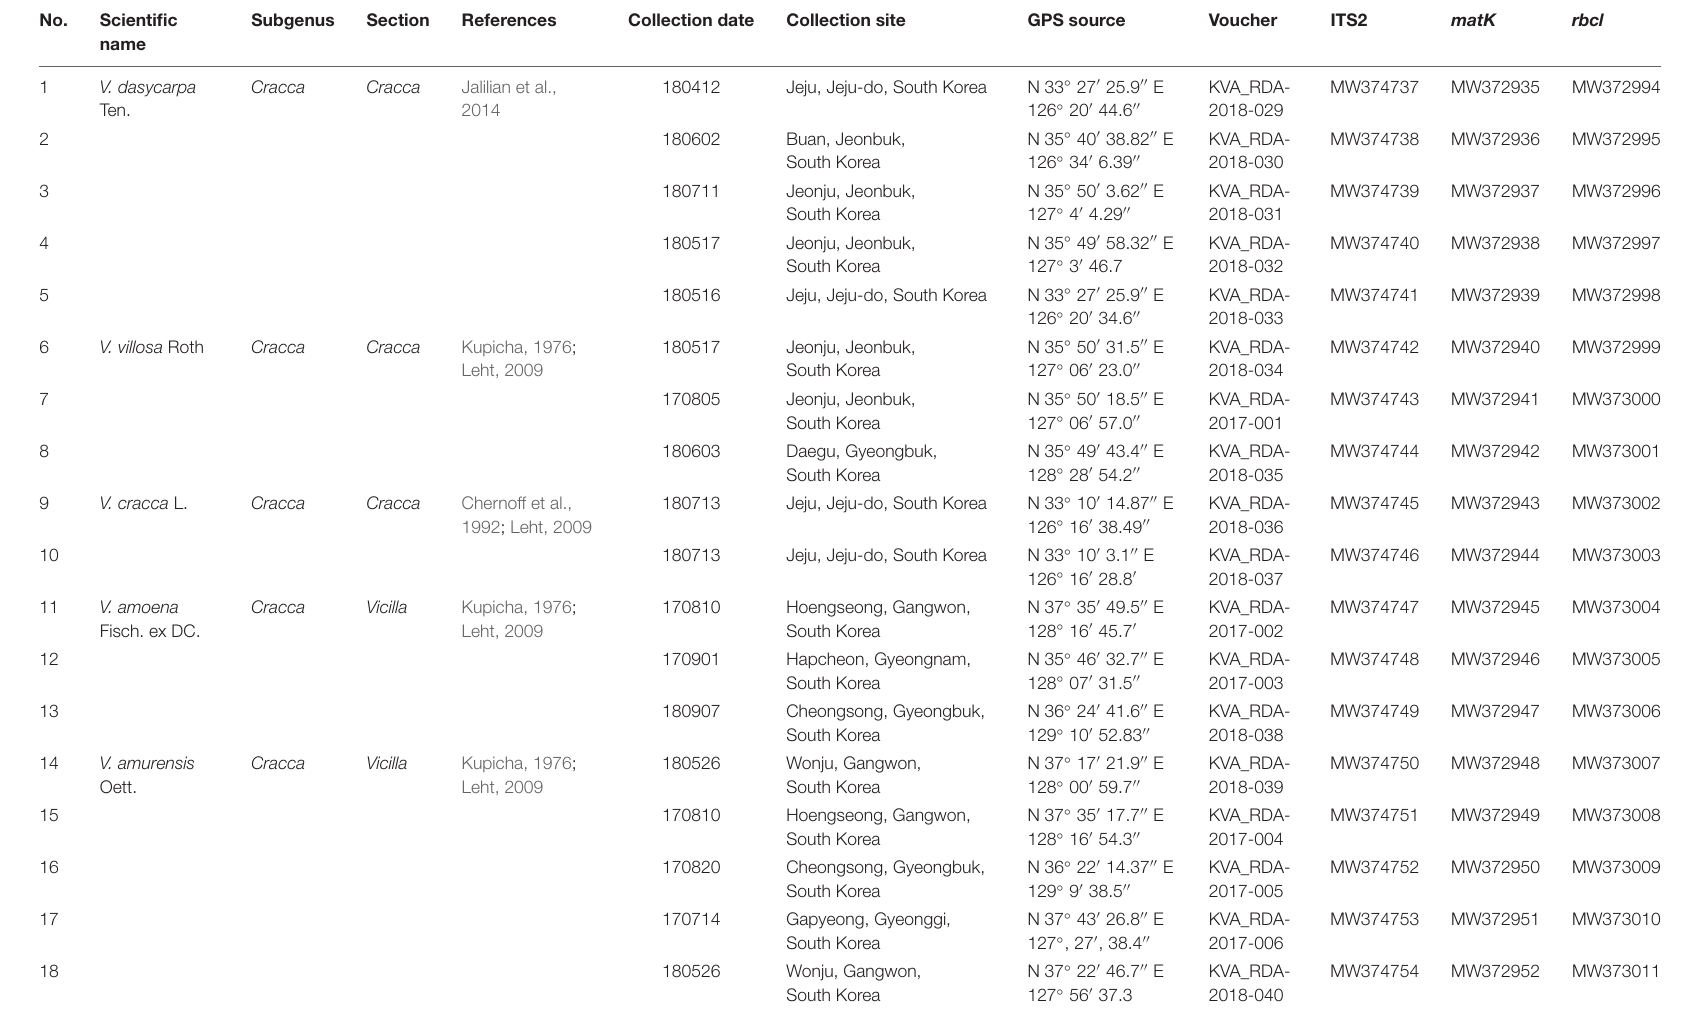
TABLE 1 | List of plant species used in this study along with the collection site, GPS source, and voucher number.